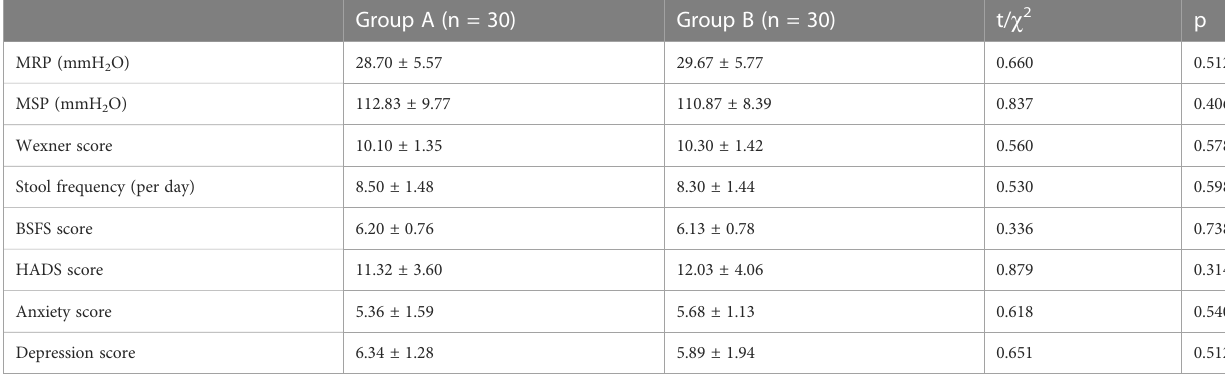
TABLE 2 Baseline data for the two study groups (all patients with